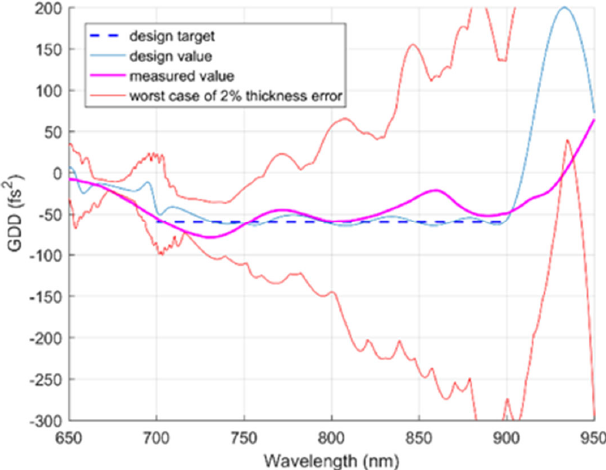
Figure 15. Comparisons of the GDD response among the design target, the design values, the measured values, and bound of GDD deviations under the worst ‐ case scenario of thickness error at 2%.